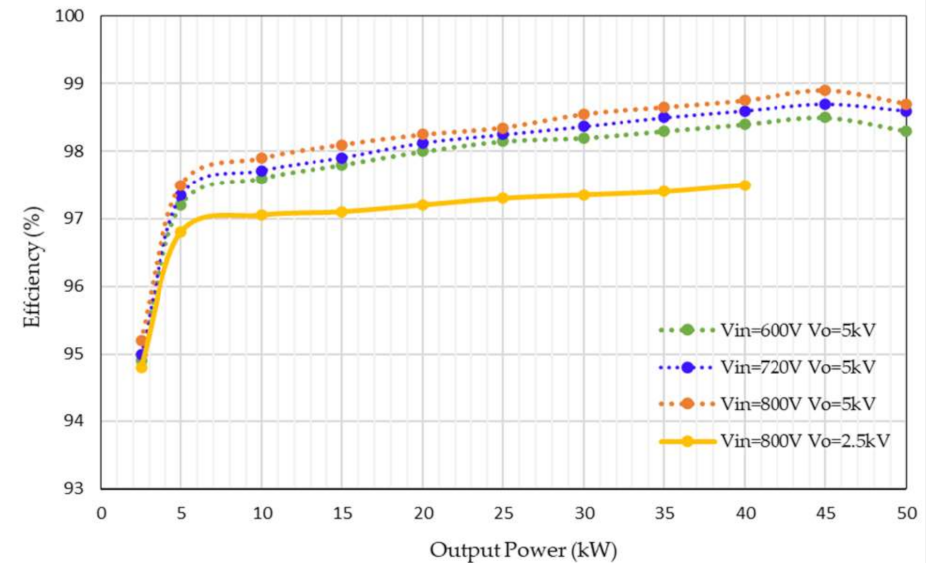
Figure 21. Measured efficiency of the dc–dc module.